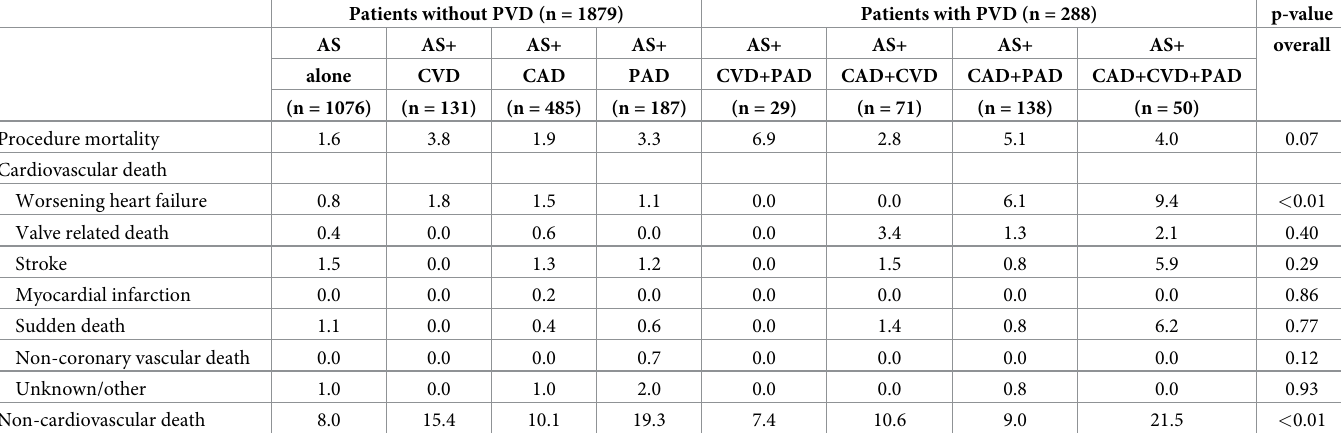
Table 6. The sub-analysis of the causes of death of patients with individual VB disease for 2 years. Patients without PVD (n =